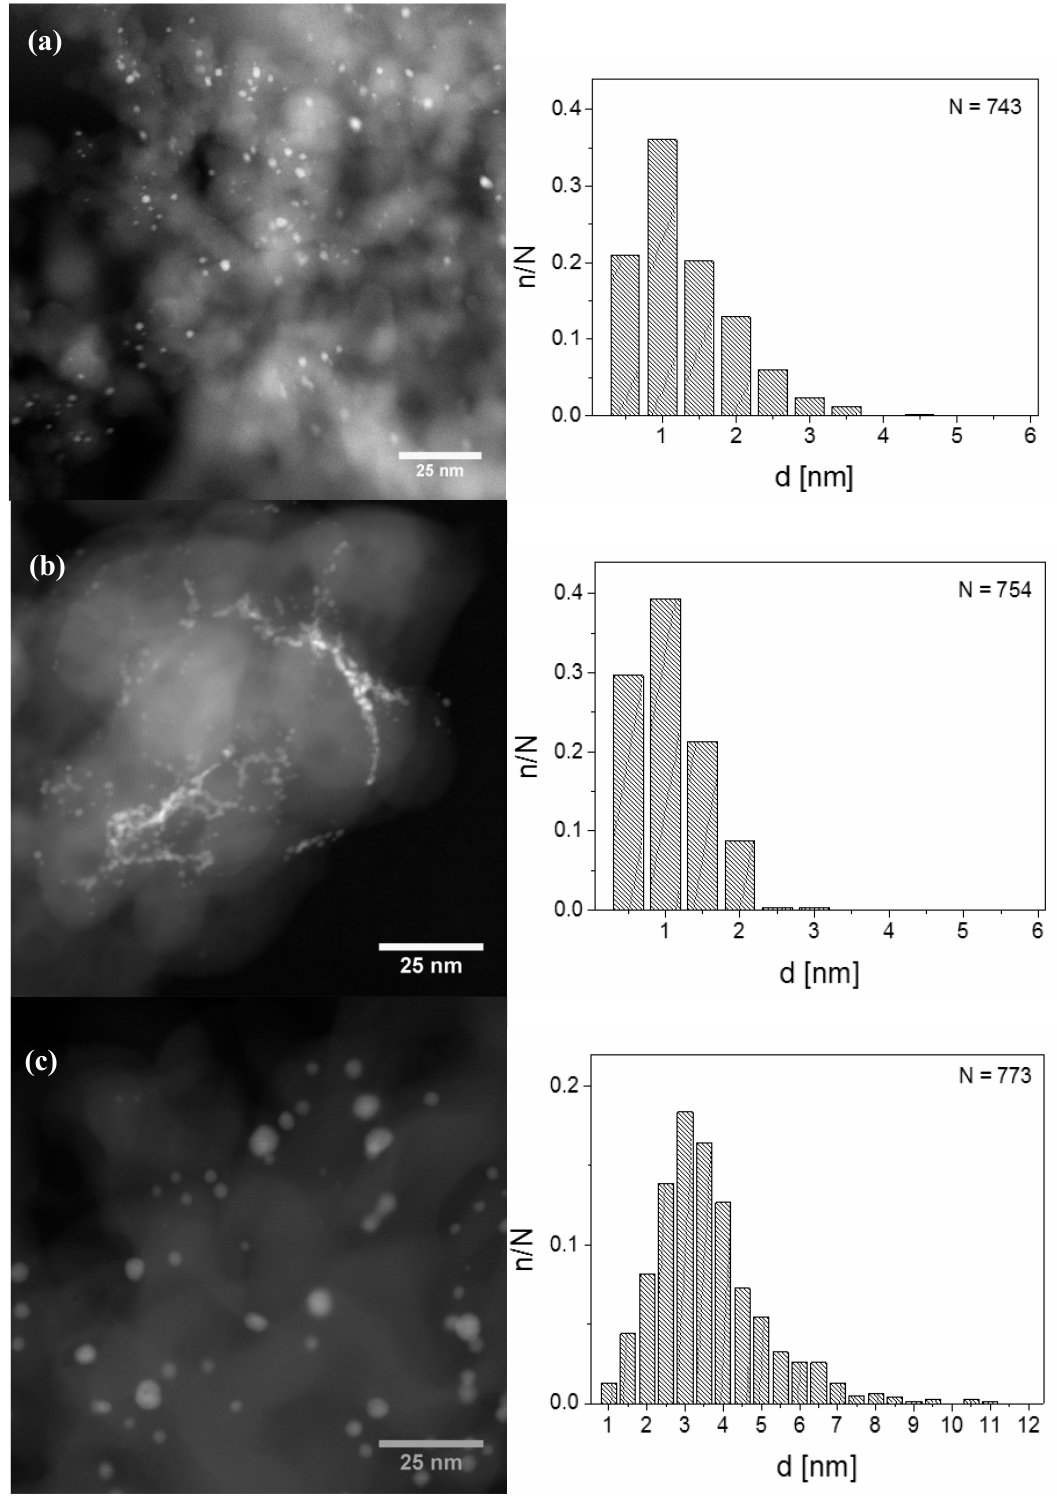
Figure 1. STEM images and particle size distribution of 1 wt. % Pt/SiO 2 ( a ); 1 wt. % Pt/H-MFI-90 ( b ); and 1 wt. % Pt/H-MFI-90 after the catalytic measurement at 250 °C ( c